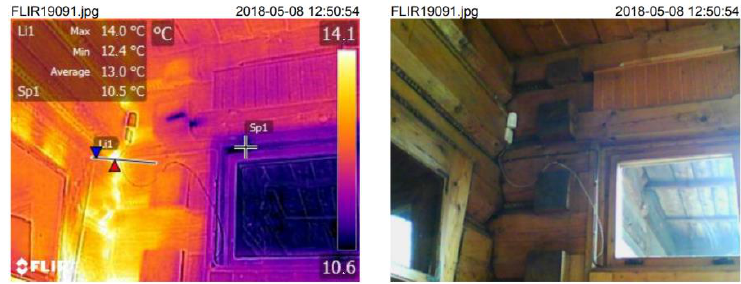
Figure 6. Leak detection in the building envelope using a thermal imaging camera [30].